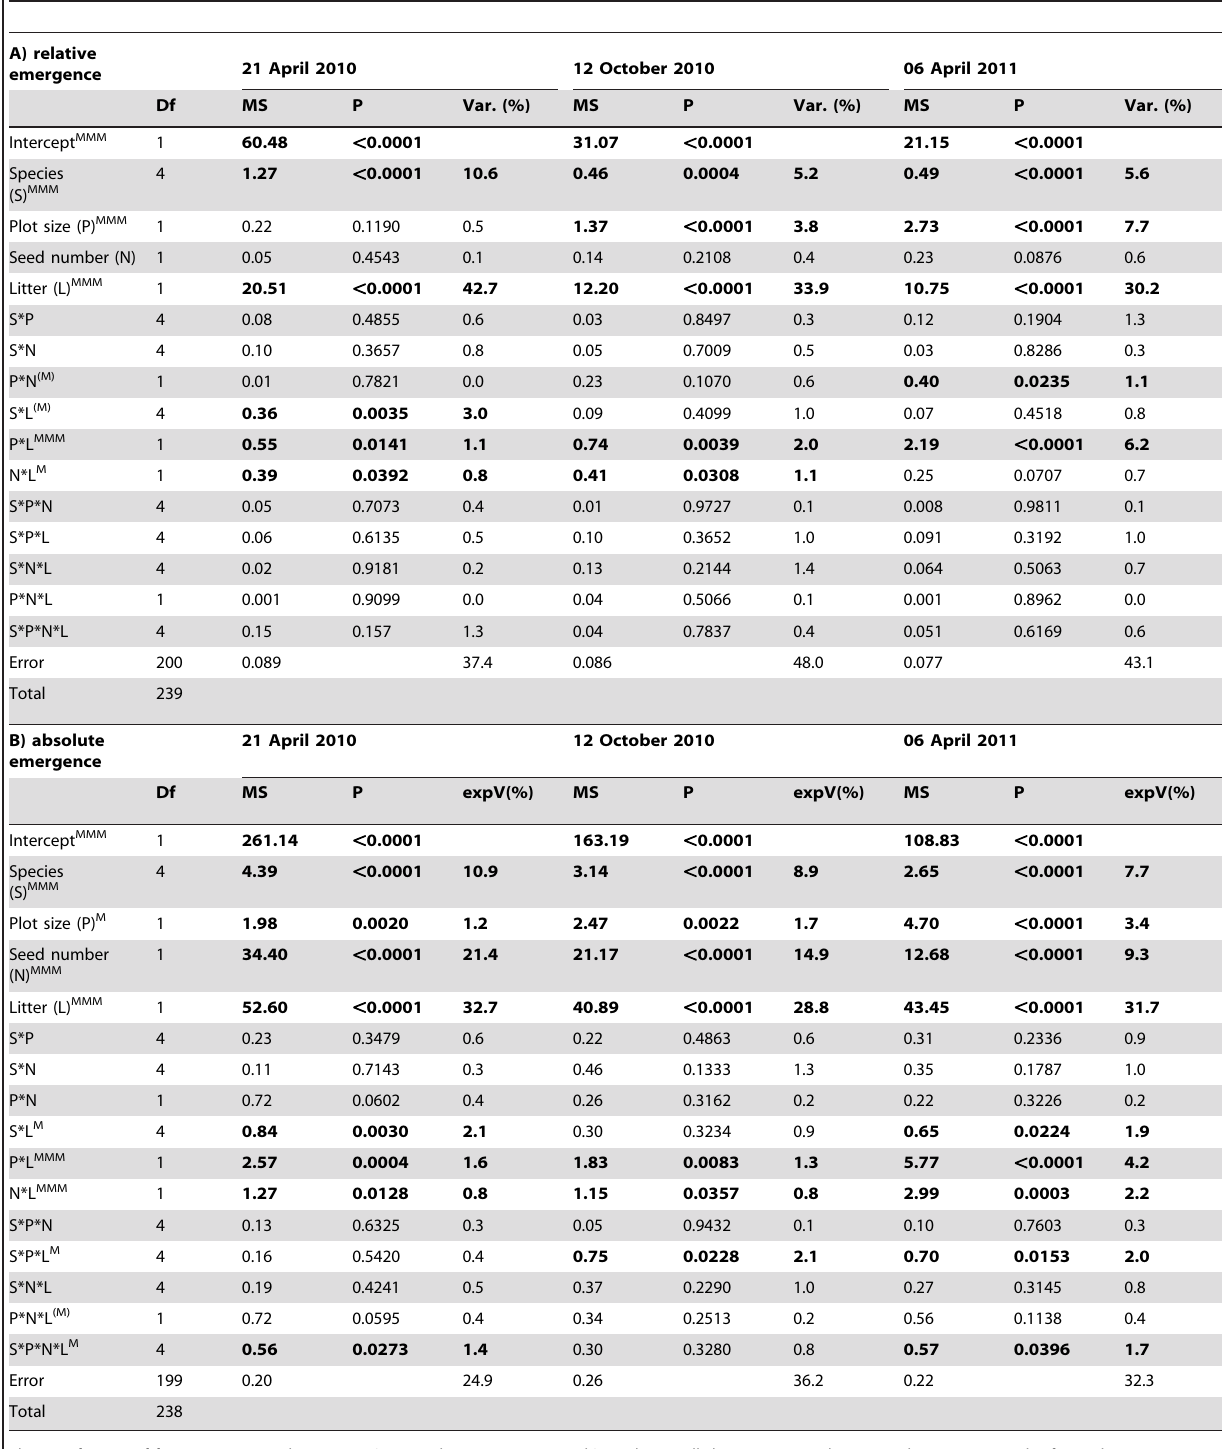
Table 2. Univariate results of a repeated measures ANOVA testing for the effects of species identity, plot size, seed number, litter and time on relative (A) and absolute (B) seedling